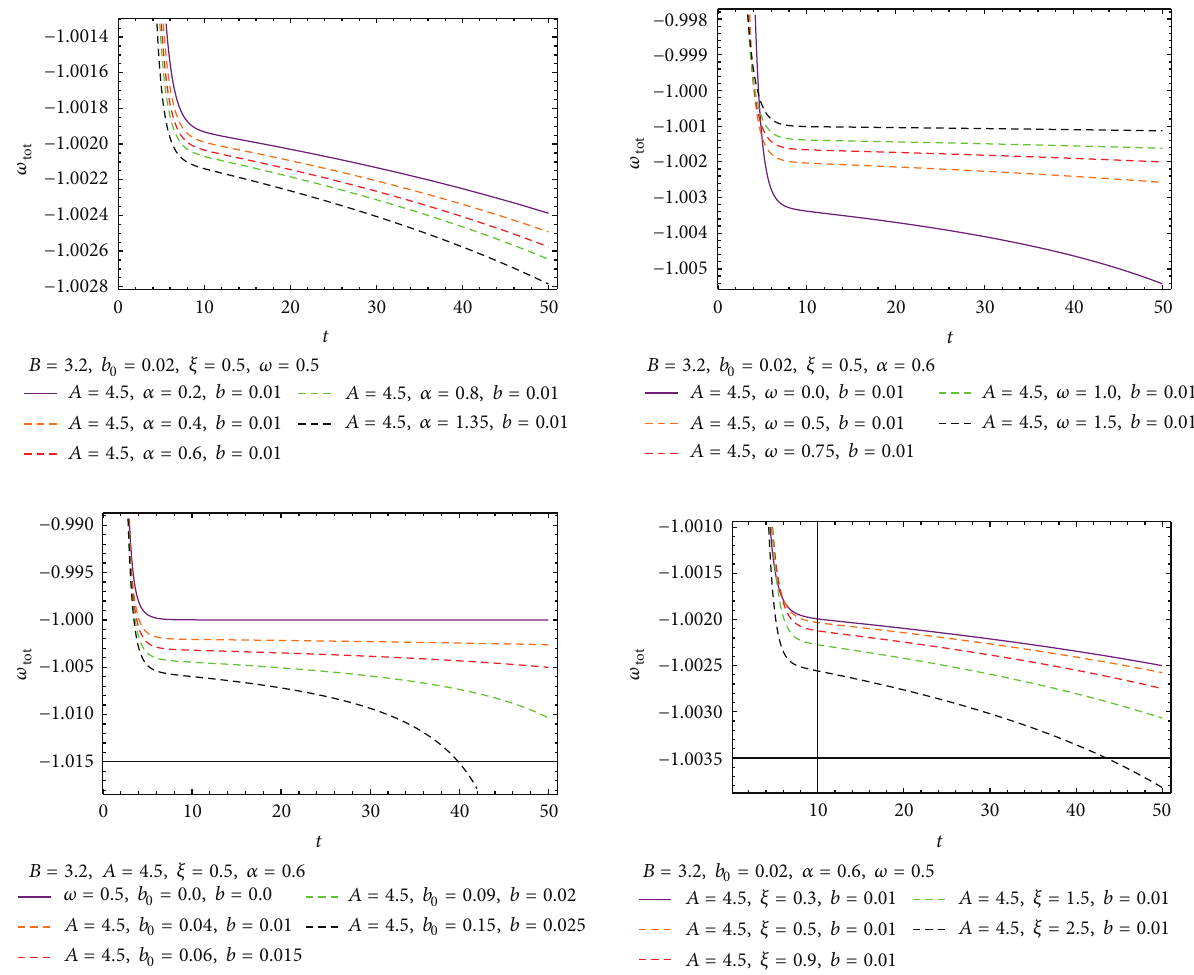
Figure 2: Behavior of EoS parameter 𝜔 against 𝑡 for interacting barotropic fluid and viscous modified Chaplygin tot